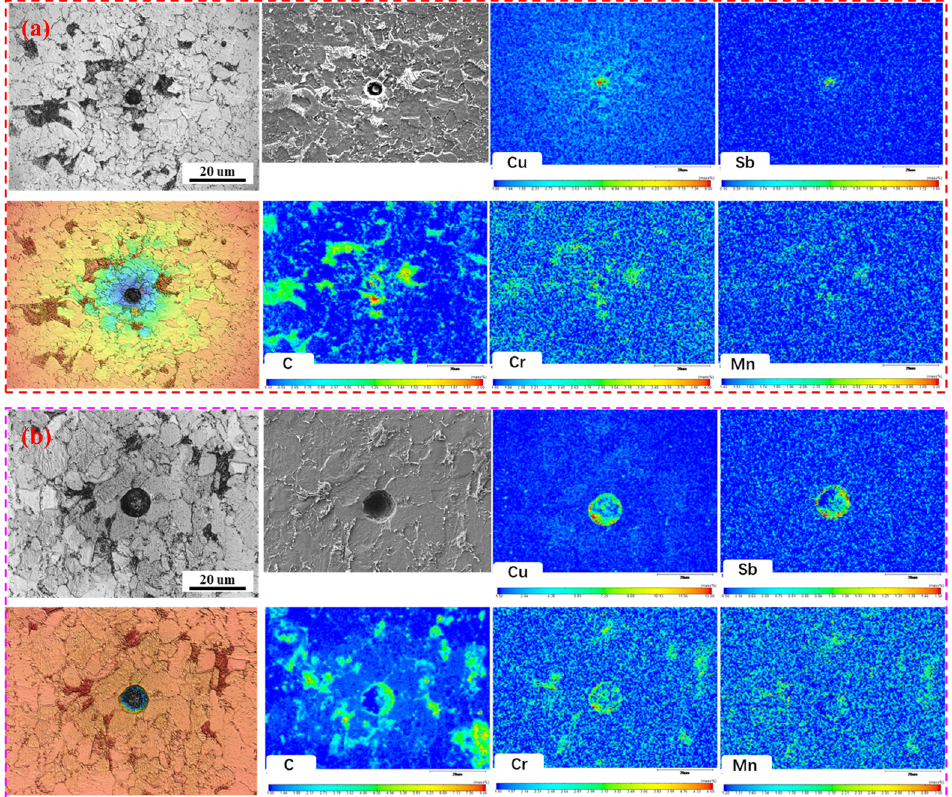
Fig. 14 The corrosion morphology and distribution of corrosion-resistant elements in matrix and pearlite region of inclusion boundary. a EPMA analysis after 1800 s immersion and b EPMA analysis after 3600 s immersion.